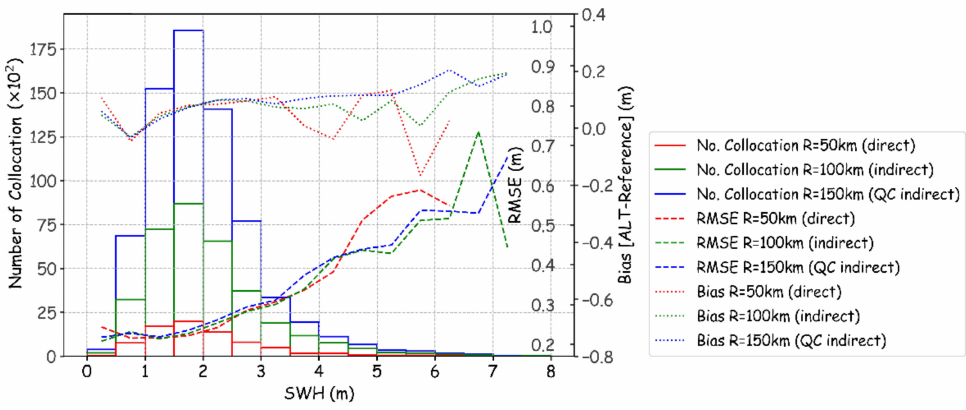
Figure 3. The N col , CCs, and RMSEs of Envisat SWHs as a function of reference SWH. Each type of validation is represented by a di ff erent color. Red: direct validation; Green: indirect validation without QC; Blue: indirect validation with a QC of G < 0.6 m. The overlaid histograms show the number of collocations, dashed lines show RMSEs, and the dotted lines show the bias at each SWH bin (0.5 m